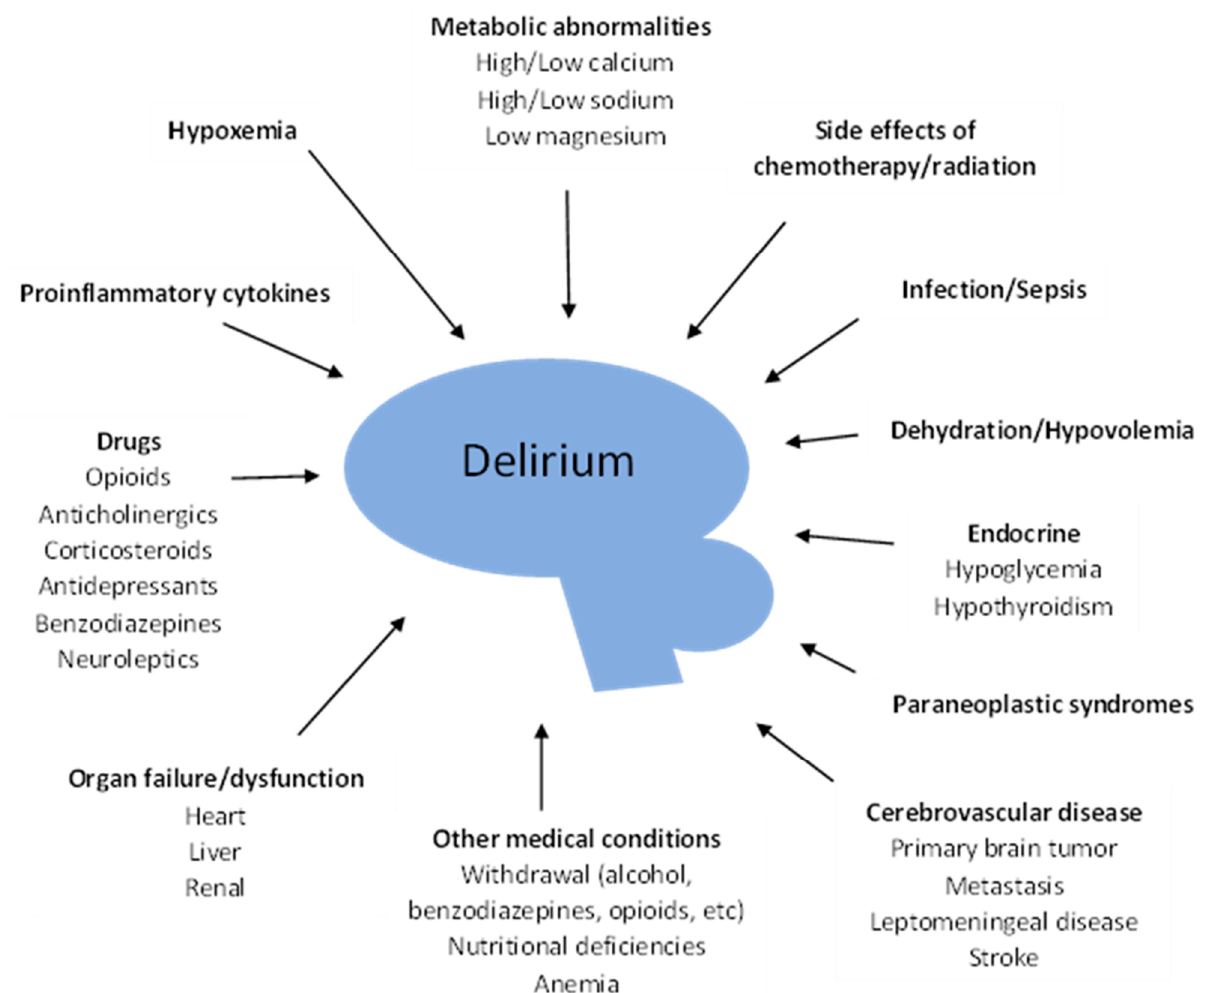
Figure 1. Factors associated with delirium in cancer patients [32].